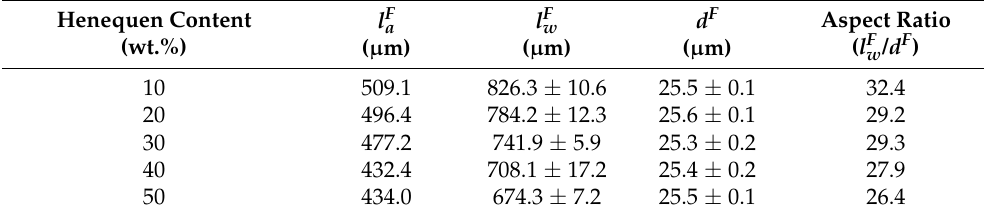
Table 4. Morphology of the fibers extracted from the different compounds produced.